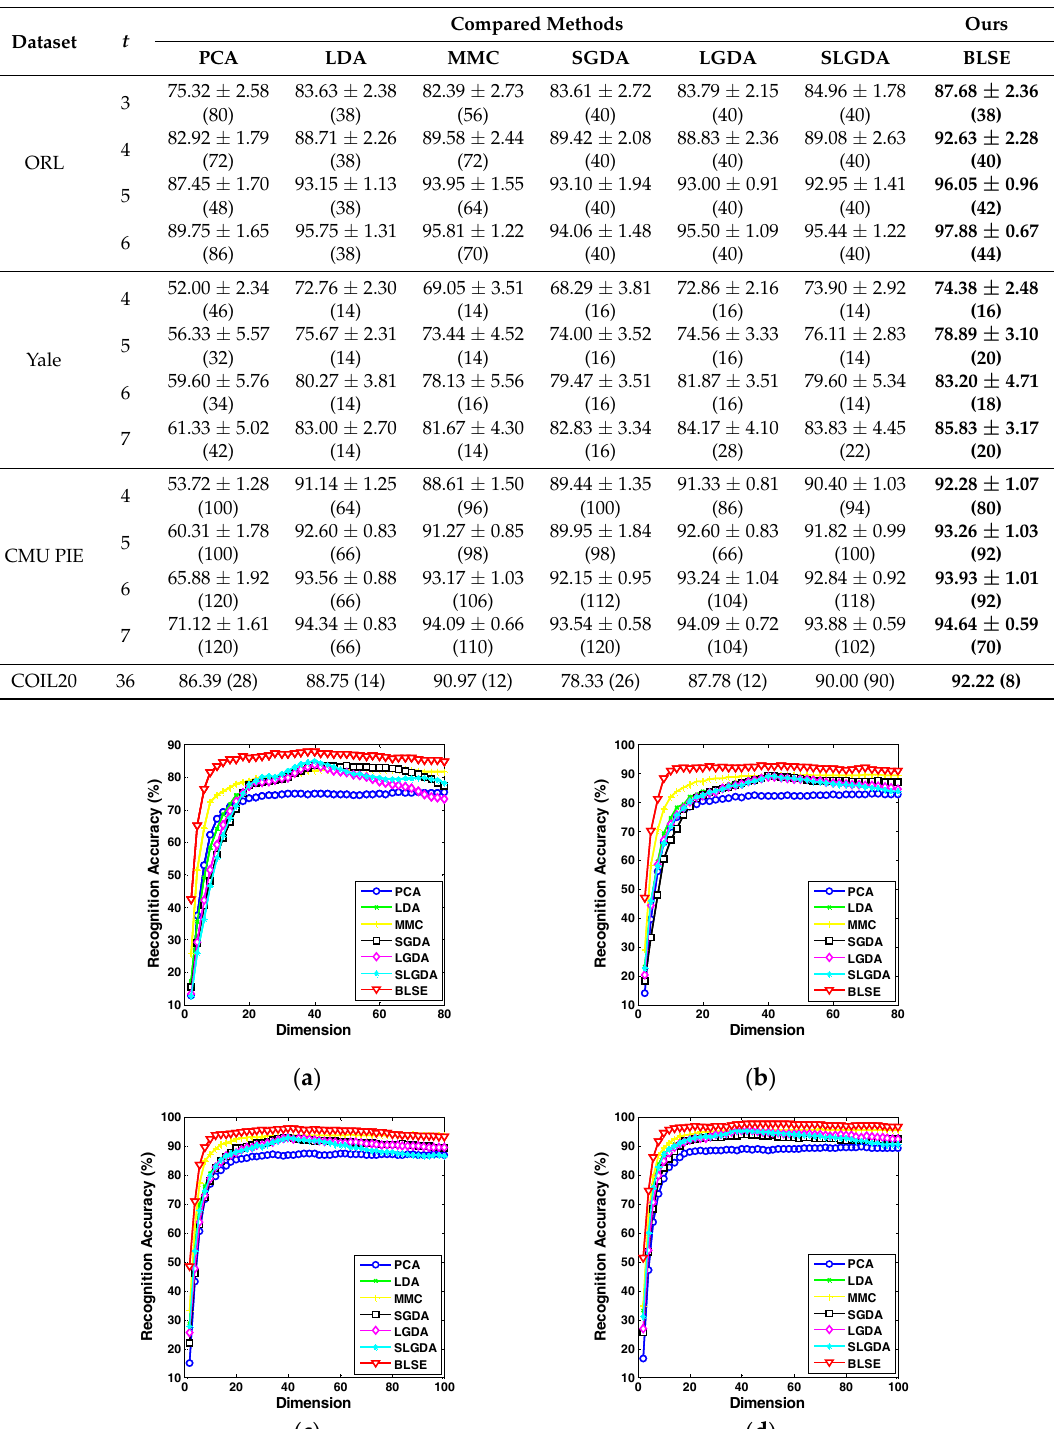
Table 1. Recognition rates (%) and the corresponding standard deviations and dimensions (in parenthesis) on ORL, Yale, CMU PIE and COIL20 databases.